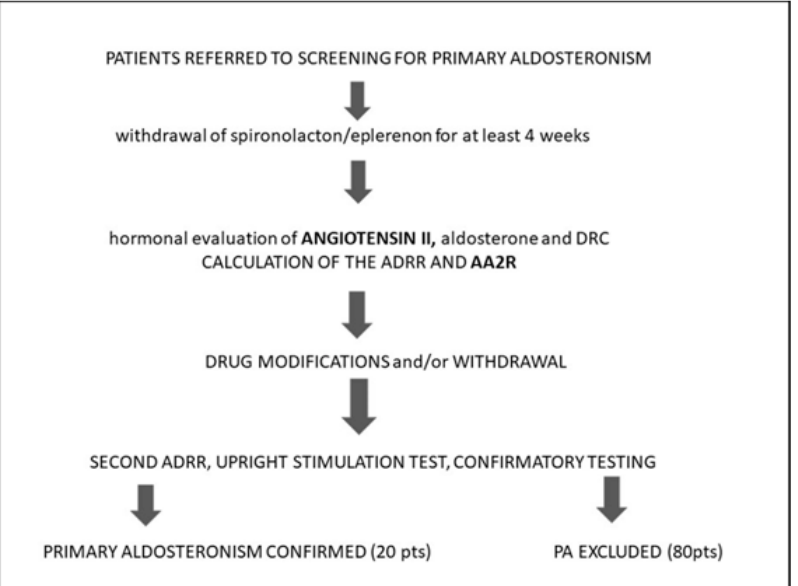
Figure 1. The study protocol. The study cohort included the population referred to screening for primary aldosteronism. Of all antihypertensives, only MRAs were excluded before the first screening test. The participants underwent hormonal evaluation of angiotensin II, aldosterone, and DRC. ARR and AA2R were calculated. After the first screening test, the patients were properly prepared and further diagnosed until the final diagnosis which revealed 20 cases of PA.